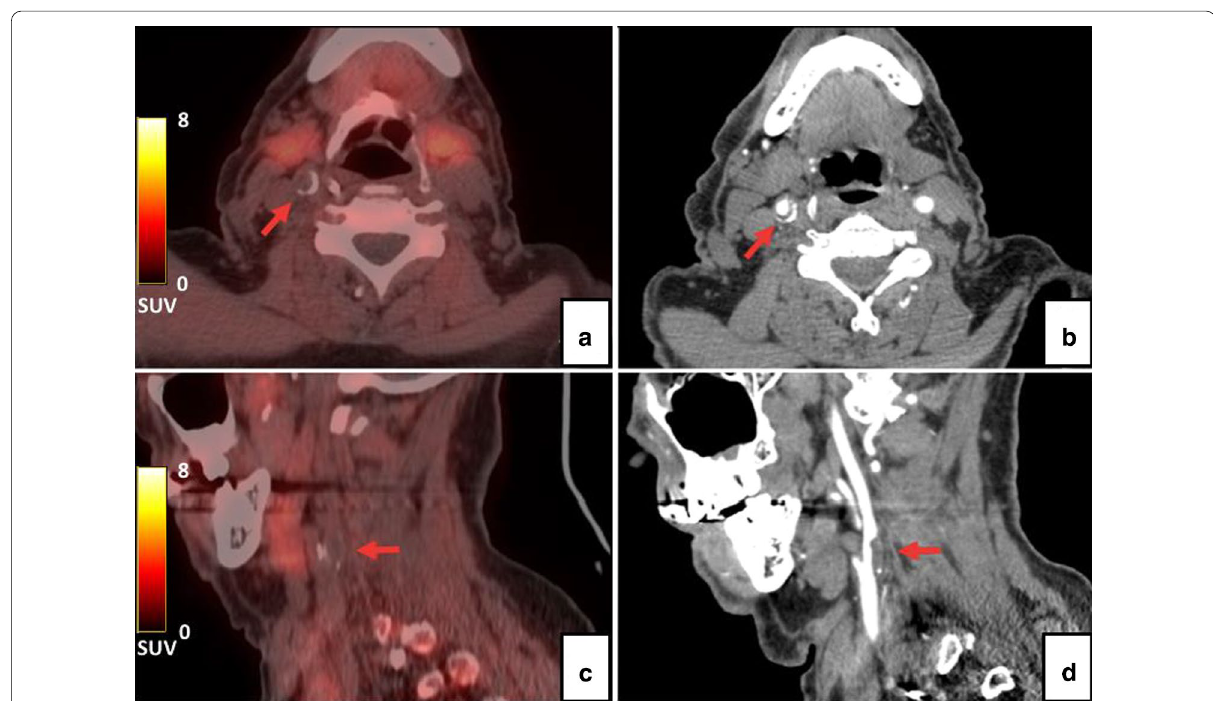
Fig. 5 A representative [ 18 F]‑PBR06 PET/CT (A, C) scan and angio‑CT (B, D) scan. No uptake was observed on the right carotid atheromatous